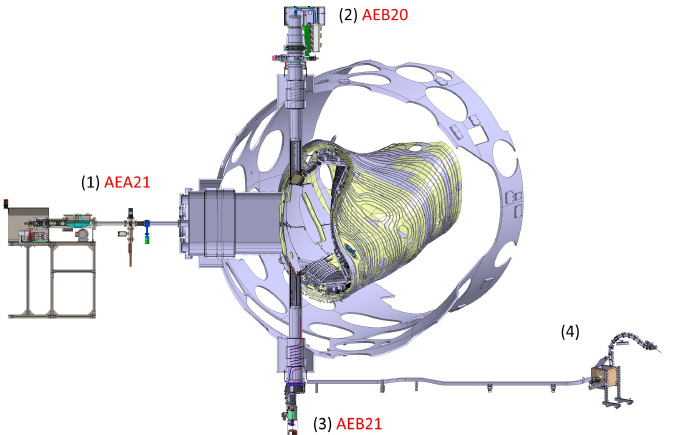
Figure 3. The entire W7-X alkali metal beam diagnostic system (section view) with the injector (1), first observation system (2), second observation system (3), and the optical fiber patch box